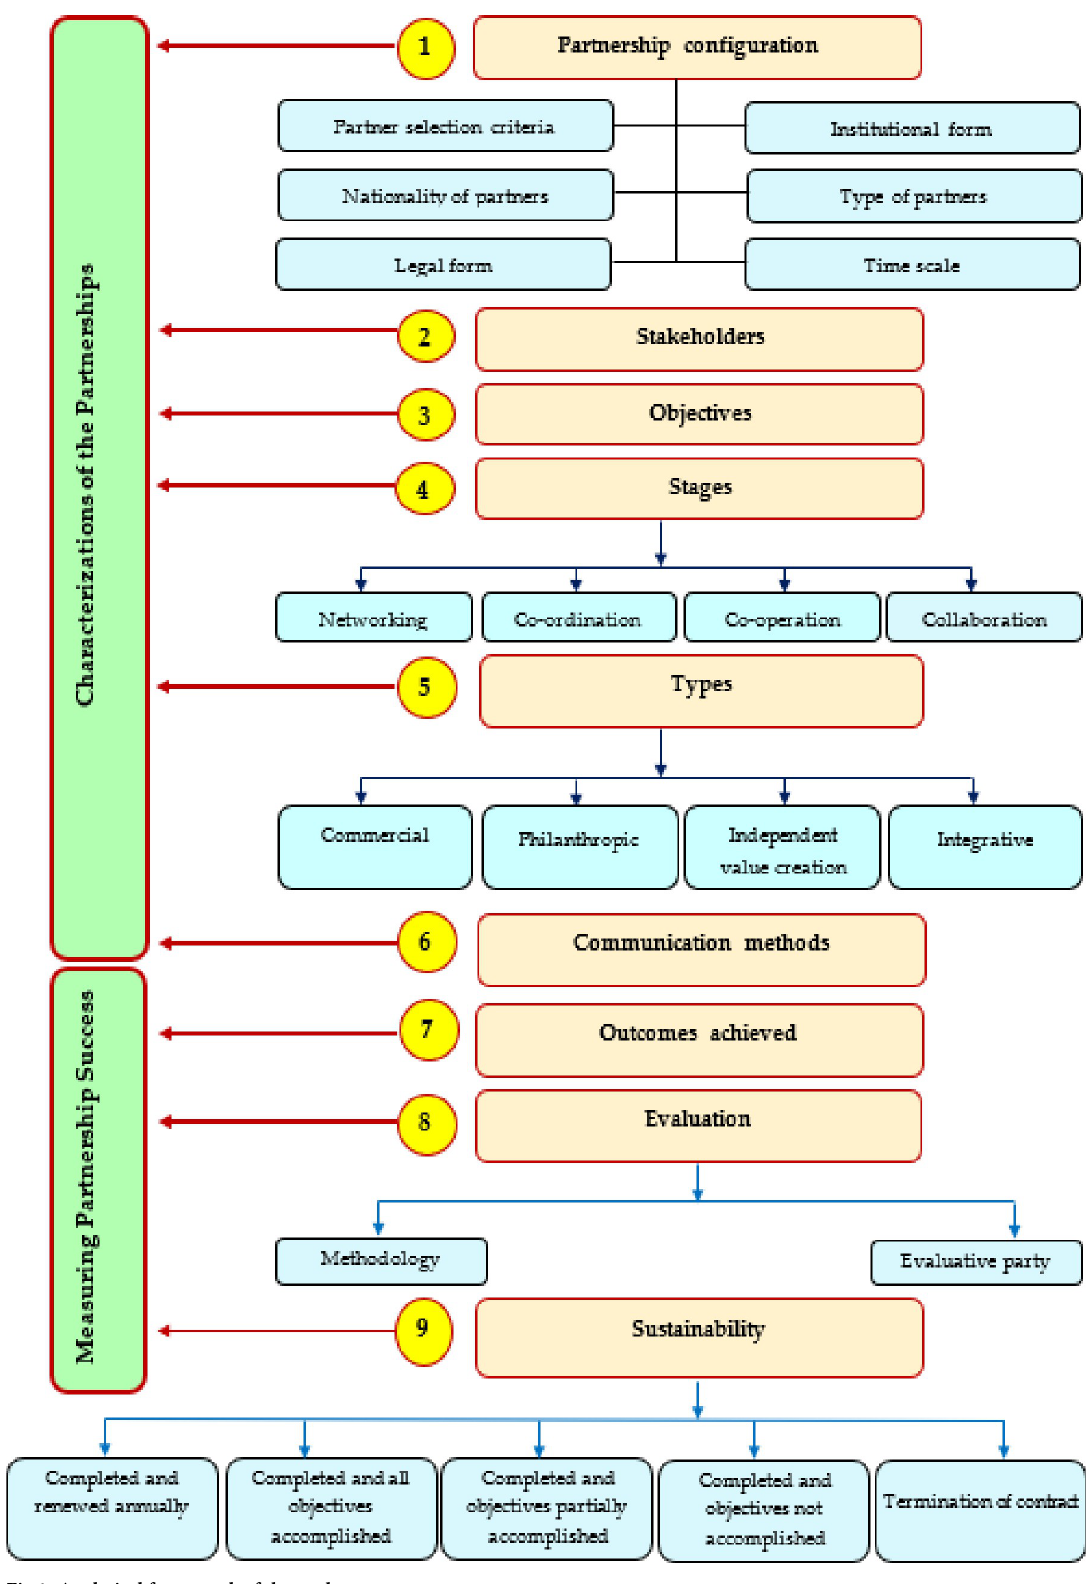
Fig 1. Analytical framework of the